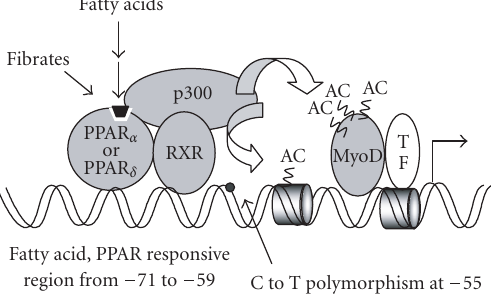
Figure 2: Schematic representation of the regulation of UCP3 gene transcription by PPARs. The proximal region responsive to PPAR α and 55 C to T polymorphism is adjacent to this region. MyoD and TFs indicate the PPAR δ activation via PPAR/RXR heterodimers is shown. The (cid:0) binding of MyoD and of basal transcription factors, respectively, close to the site of transcription initiation. P300, the main coactivator linking ligand-dependent activation of PPARs with transcriptional activation is shown. AC indicates the acetylation sites involved in transcriptional